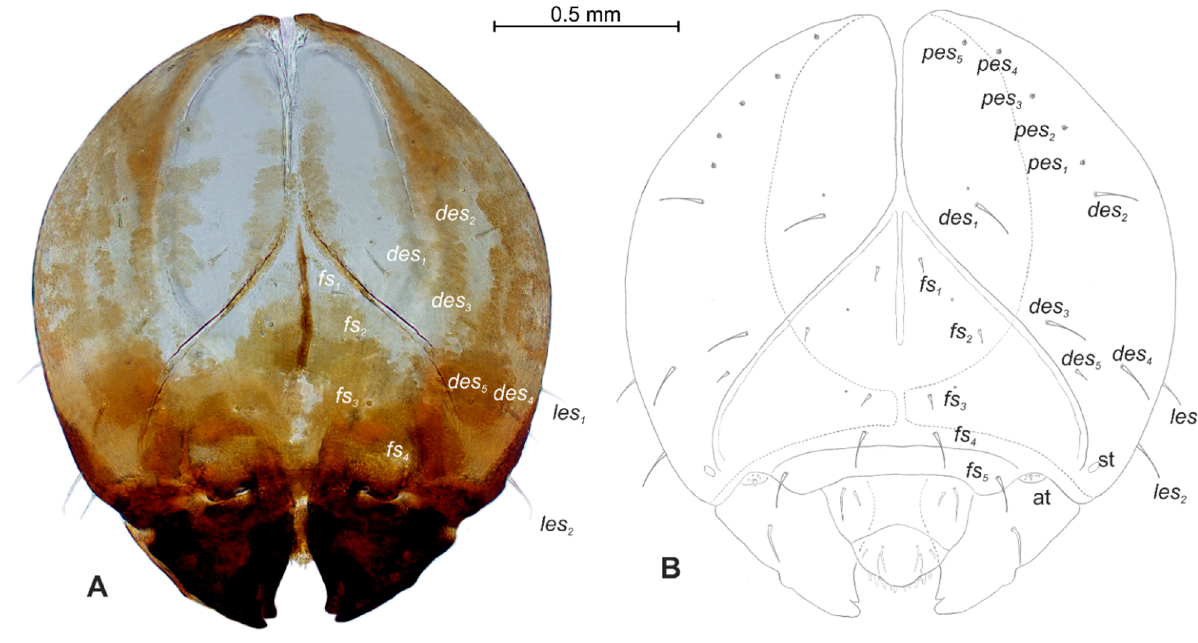
Figure 14. Rhinocyllus alpinus mature larva, head. ( A )—frontal view of head, photo; ( B )—frontal view of head, scheme; (at—antenna, st—stemmata, setae: des —dorsal epicranial, fs —frontal, les —lateral epicranial, pes —postepicranial).